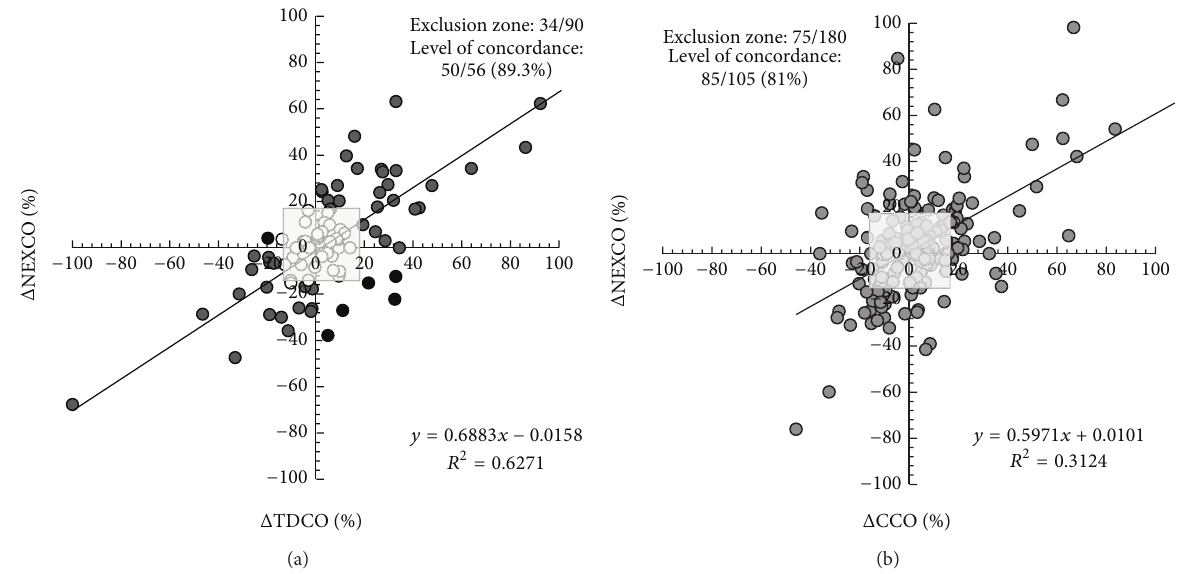
Figure 3: Four quadrants trend plot. (a) Plot for 90 paired measurements of Δ NeXCO and Δ TDCO. From the 90 initial paired measurements, 34 pairs were excluded (exclusion zone is indicated as grey dots within grey-shaded square) because either Δ NexCO or Δ TDCO was ≤ ± 15% or because Δ NexCO or Δ TDCO was equal to zero. The calculated level of concordance was 89.3% (50/56) (6 pairs felt within the upper left or lower right quadrant and correspond to poor concordance, black dots). See text for explanation. (b) Plot for 180 paired measurements of Δ NeXCO and Δ CCO. From the 180 initial paired measurements, 75 pairs were excluded (exclusion zone is indicated as grey-shaded square) because either Δ NexCO or Δ CCO was ≤ ± 15% change or because Δ NexCO or Δ CCO was equal to zero. The calculated level of concordance was 81% (85/105). See text for explanation.